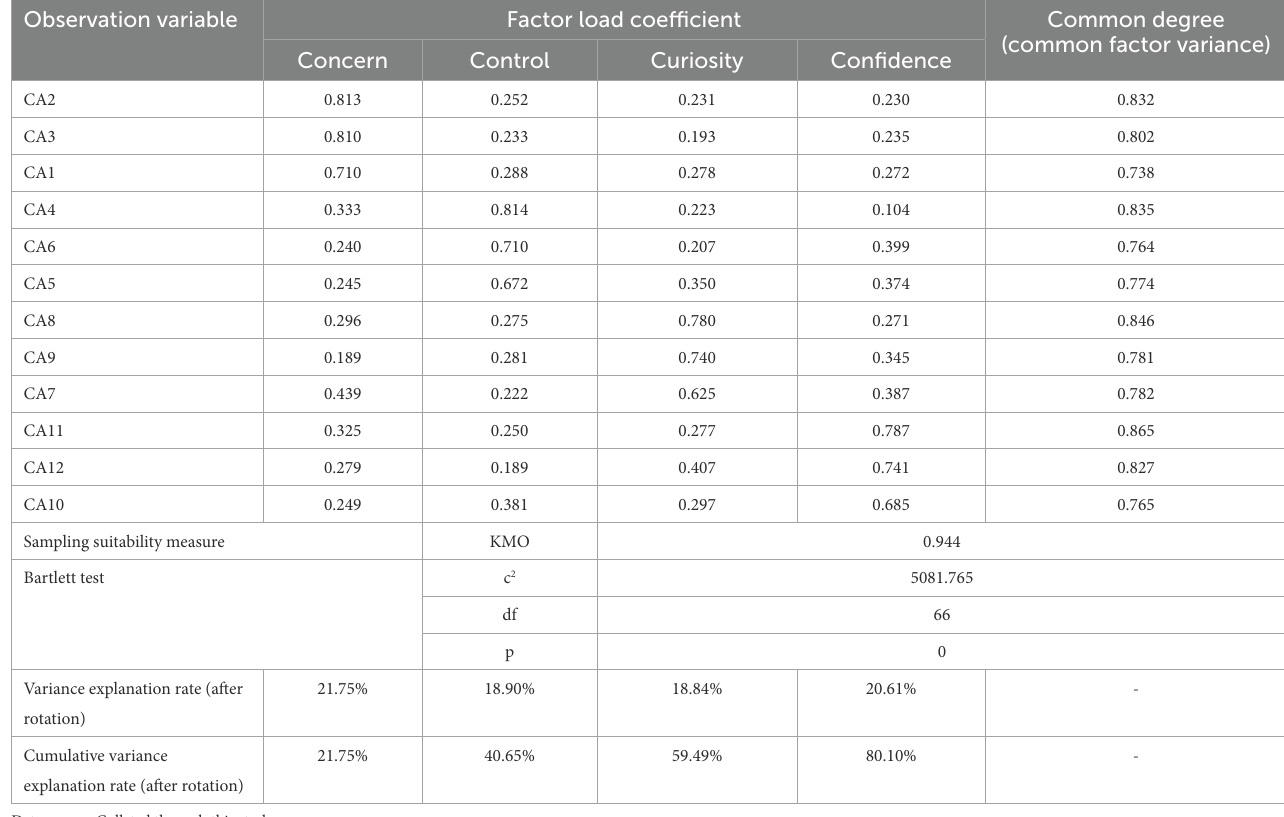
TABLE 2 The EFA Results of CAAS-SF China. Observation variable